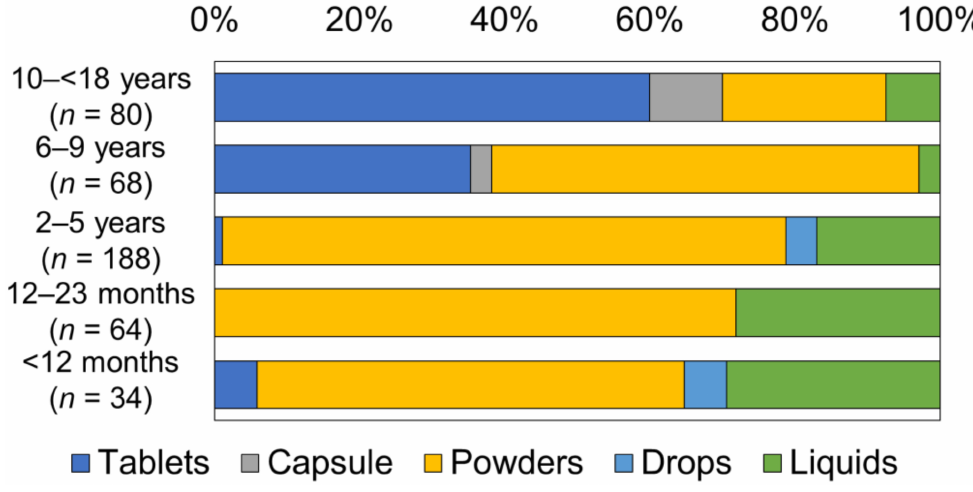
Figure 2. The frequencies of prescribed dosage forms in each age group.